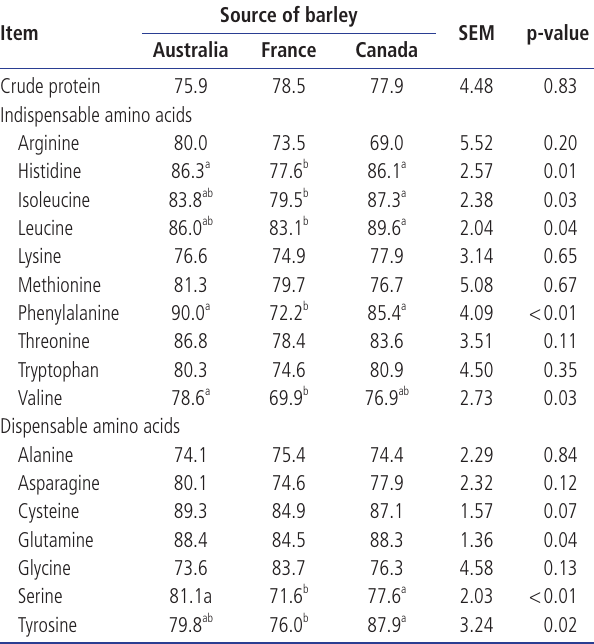
SEM, standard error of the mean. 1) Data are means of 6 observations for all treatments; Values for standardized ileal digestibility were calculated by correcting values for apparent ileal digestibility for basal ileal endogenous losses and the basal ileal endogenous losses were determined (g/kg dry matter intake) as crude protein, 31.63; arginine, 0.41; histidine, 0.18; isoleucine, 0.37; leucine,0.73; lysine, 0.49; methionine, 0.13; phenylalanine, 0.43; threonine, 0.44; tryptophan, 0.14; valine, 0.62; alanine, 0.98; aspartic acid, 0.85; cysteine, 0.22;